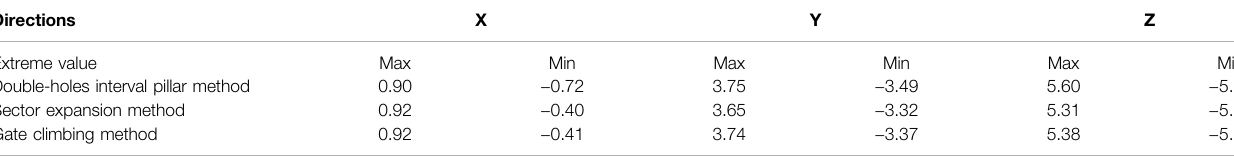
TABLE 2 | Comparison of the maximum and minimum displacement of the transfer section (unit: